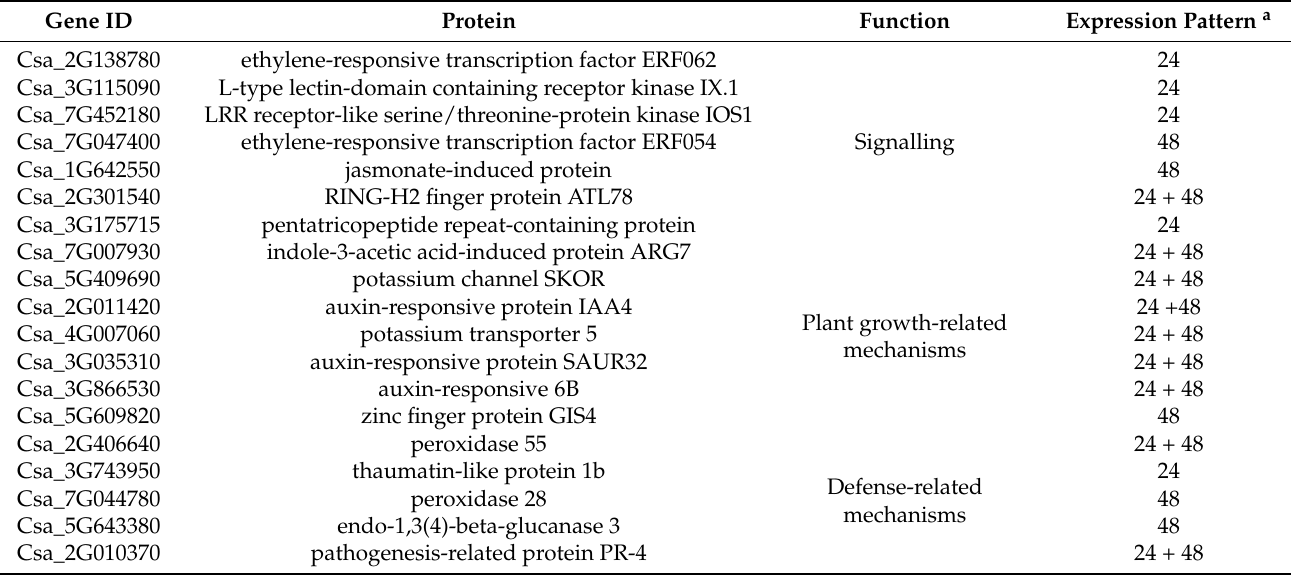
Table 1. Top up-regulated genes encoding proteins involved in signaling, plant growth, and defense in cucumber roots treated with Bacillus subtilis